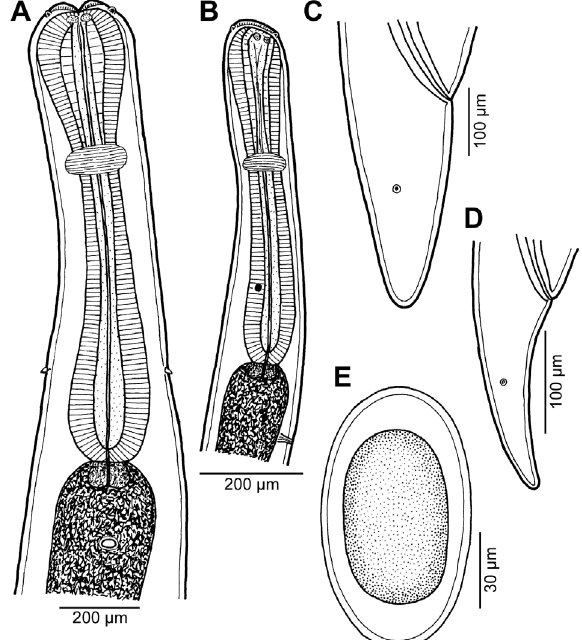
Figure 15. Cucullanus bioccai Orecchia et Paggi, 1987 from Mugil cephalus , female. (A) Anterior end of gravid specimen, ventral view; (B) anterior end of nongravid specimen, lateral view; (C, D) tail of gravid and nongravid specimens, respectively, lateral views; (E)